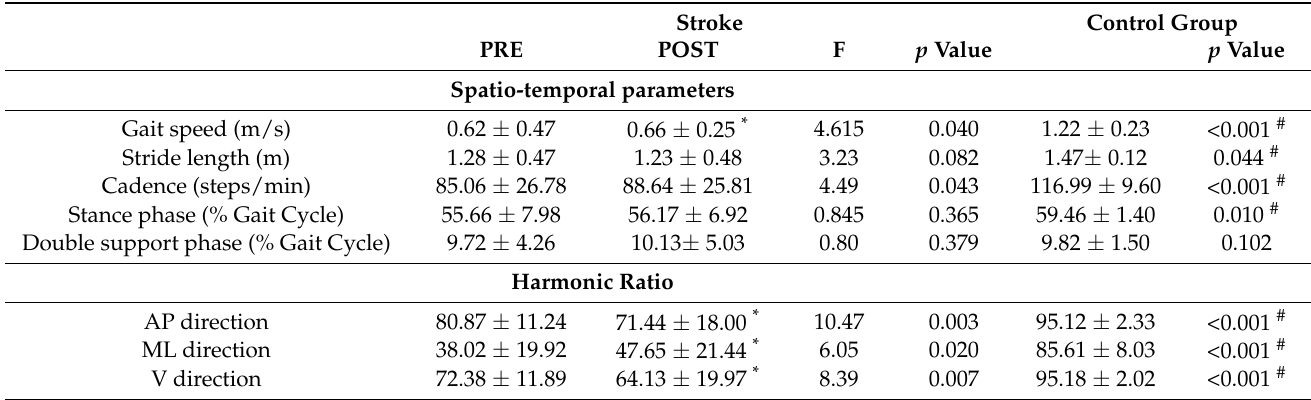
Table 2. The spatio-temporal parameters of gait and the Harmonic Ratio values of the